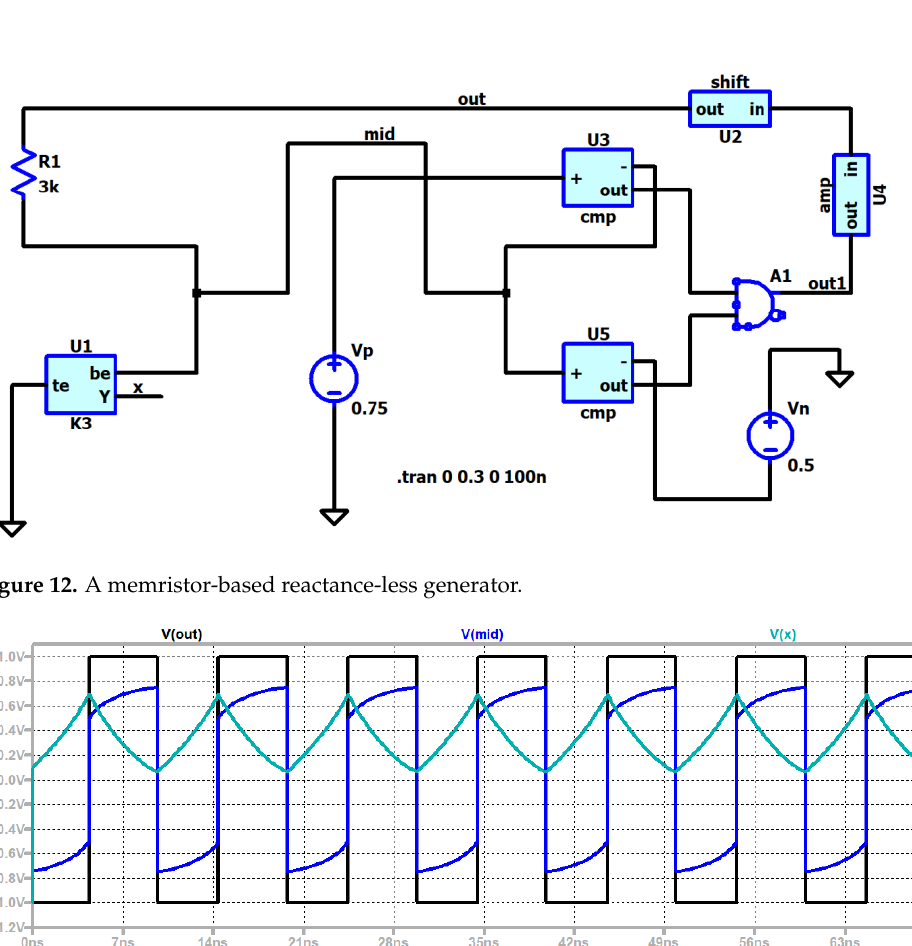
Figure 13. Time diagrams of the output voltage of the generator, the state variable, and memristor voltage according to the considered standard and modified memristor models A 11 , A 12, and A 13.